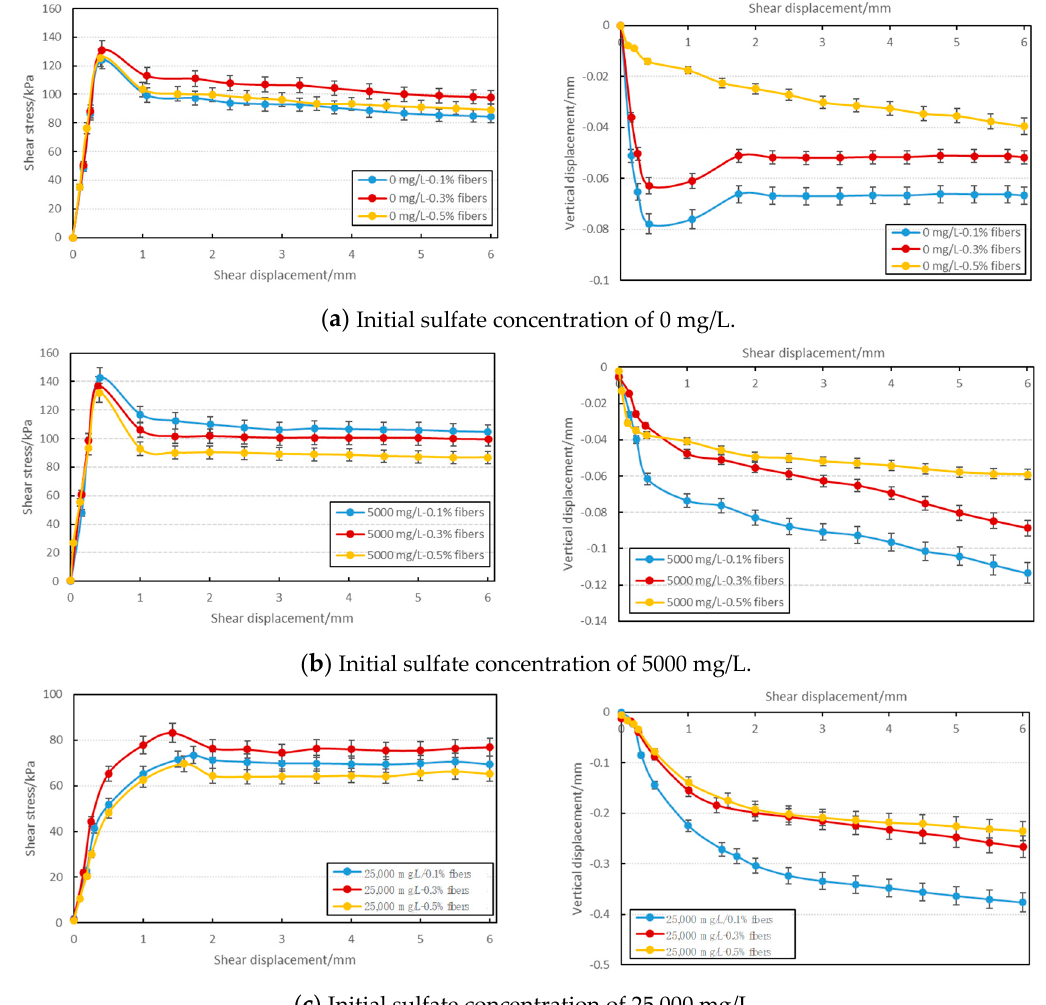
Figure 17. Plots of shear stress vs. shear displacement and vertical displacement vs. shear displacement of the FR-CPB / rock interface specimens with various fiber contents under the e ff ect of the initial sulfate concentration (treatment time of 7 days; normal stress of 100 kPa).